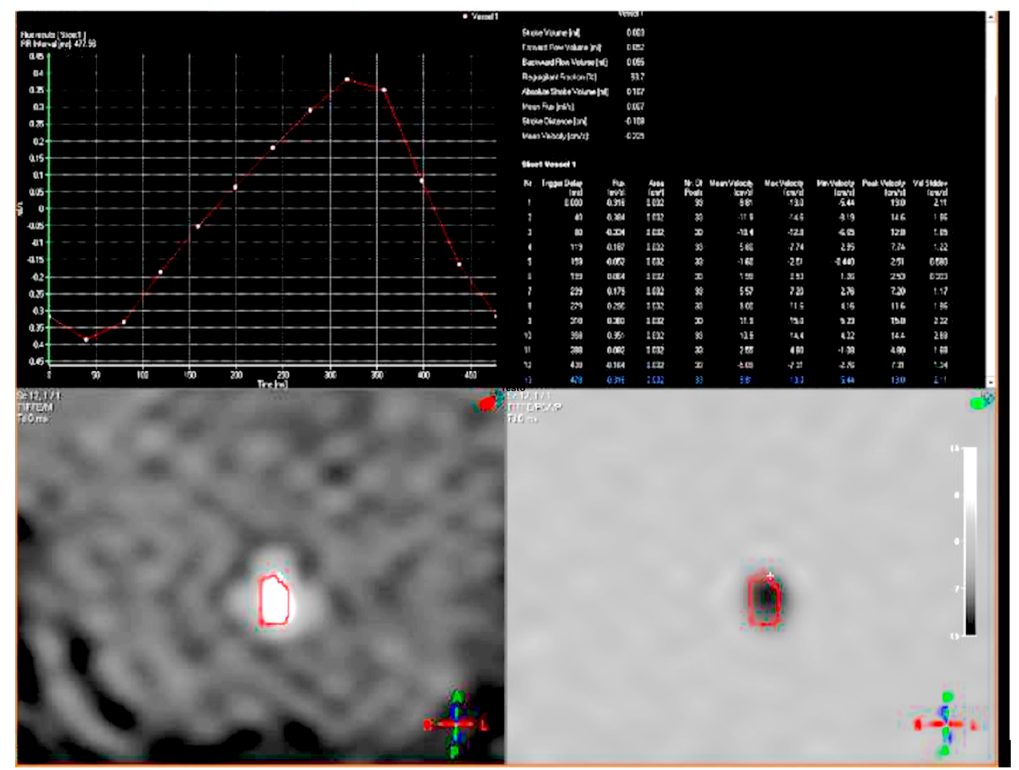
Figure 4. Cine MRI showing a flow turbulence throughout III and IV ventricles.